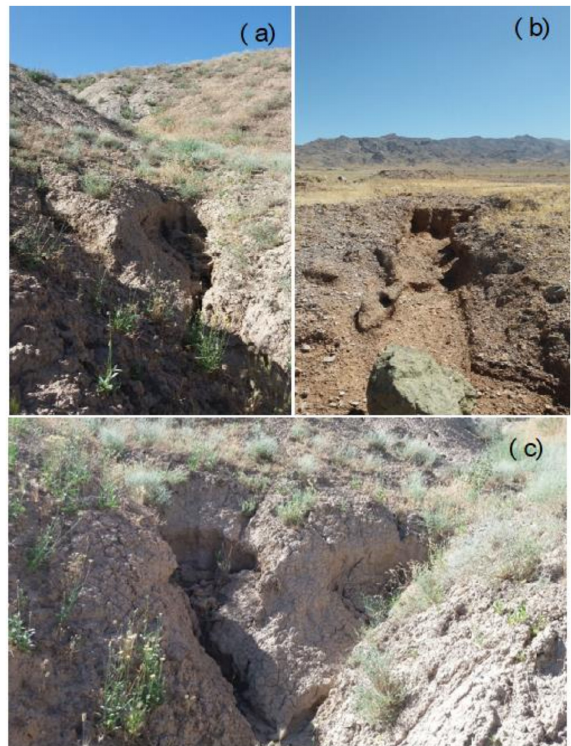
Figure 3. Some of the mapped gullies in the study area. ( a ) Lat: 377012.3; Long 4183012. ( b ) Lat: 392812.6; Long 4176965.6. ( c ) Lat: 389226.2; Long